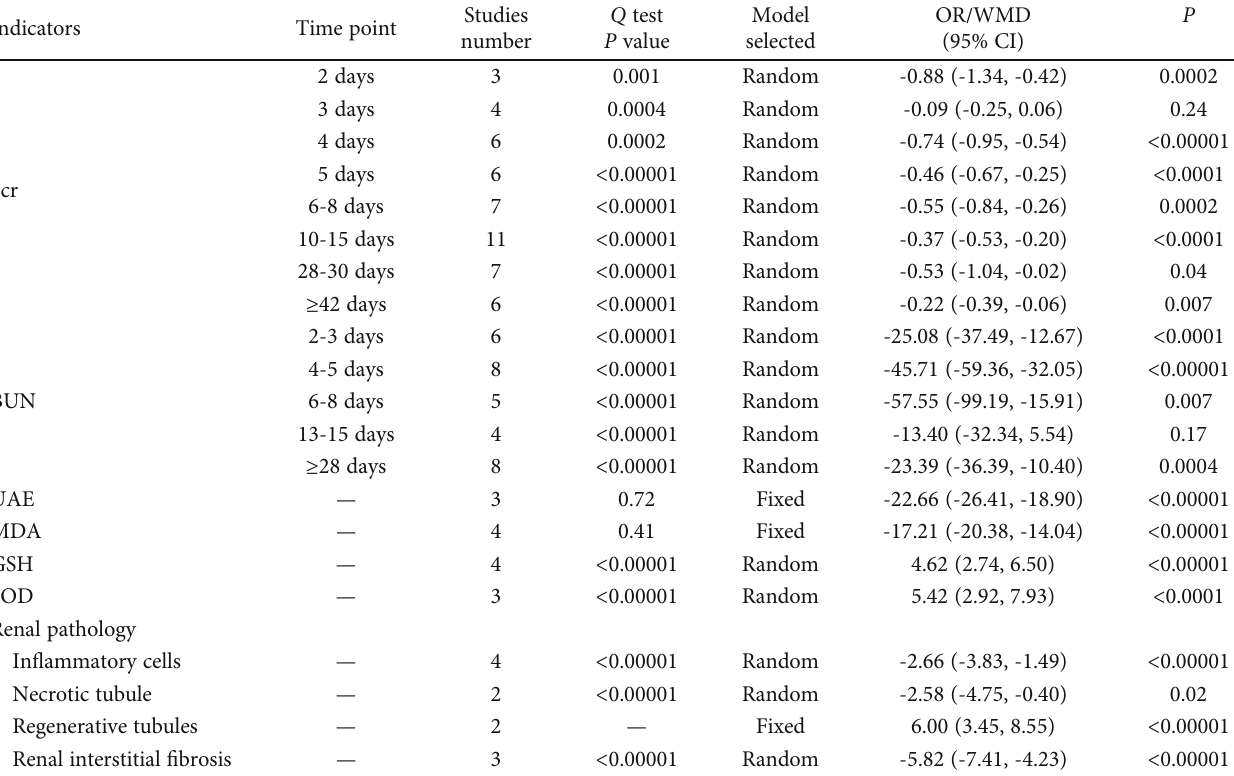
Table 2: Meta-analysis of the e ffi cacy of MSC in therapy of renal injury induced by toxicant.